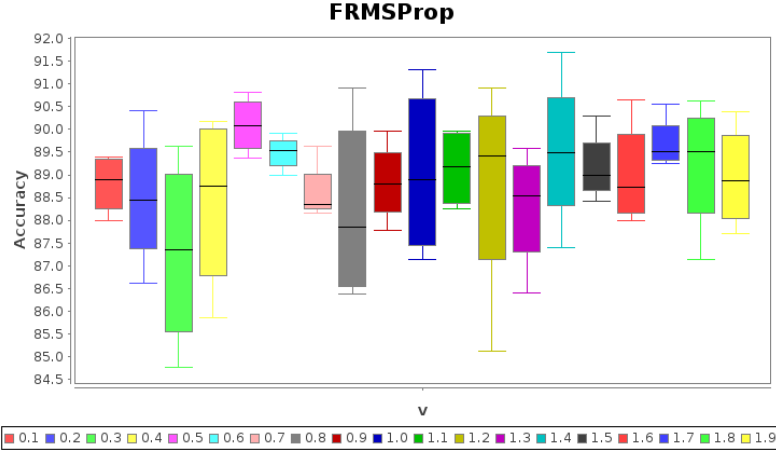
Figure 8. Experiment 2.2: FRMSProp cross-folding accuracies, K = 4 folds, ν ∈ [ 0.1,1.9 ] .